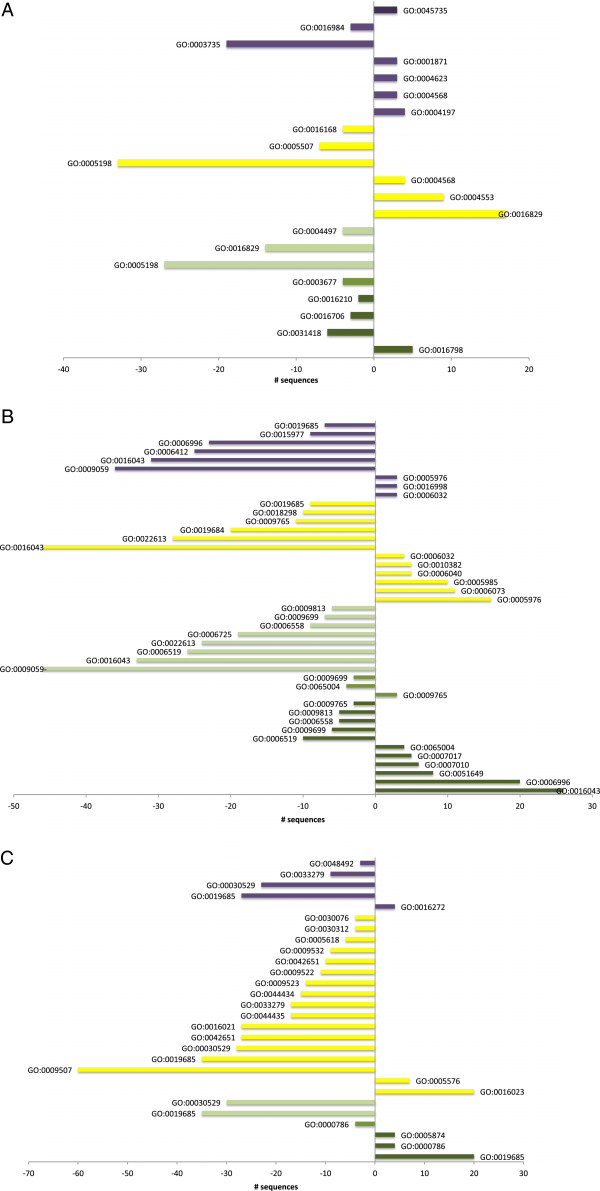
Enriched GO terms (Molecular function (F term) (A), Biological process (P term) (B) and Cellular component (C term) (C)) for the sequences annotated in the up- or down-regulated subsets of proteins in each grape berry developmental stage analyzed. Bar diagrams indicate the number of sequences that were up- and down-regulated (X-axis), annotated with each enriched GO term (Y-axis) in the consecutive paired stages. GO terms descriptions are detailed in Additional file 8. Color code for the consecutive pair stages: FS-to-4 mm transitions (dark green bars), 4 mm-to-7 mm transitions (medium intensity green), 15 mm-to-7 mm (light green), V100-to-15 mm transitions (yellow), 110 g/l-to-15 mm transitions (light purple), 140 g/l-to-110 g/l (dark purple).